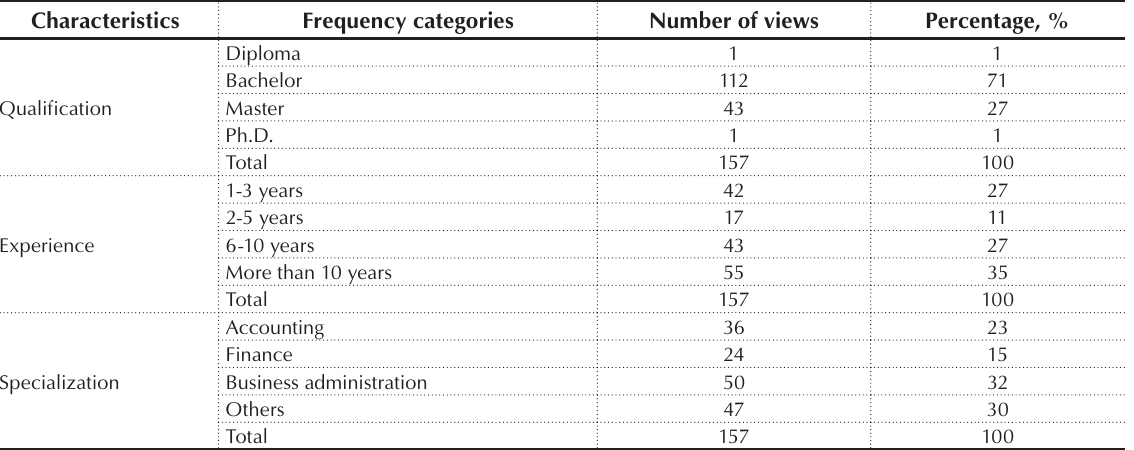
Table 3. (cid:100)(cid:346)(cid:286)(cid:3)(cid:282)(cid:349)(cid:400)(cid:410)(cid:396)(cid:349)(cid:271)(cid:437)(cid:415)(cid:381)(cid:374)(cid:3)(cid:381)(cid:296)(cid:3)(cid:400)(cid:410)(cid:437)(cid:282)(cid:455)(cid:3)(cid:400)(cid:437)(cid:271)(cid:361)(cid:286)(cid:272)(cid:410)(cid:400)(cid:3)(cid:258)(cid:272)(cid:272)(cid:381)(cid:396)(cid:282)(cid:349)(cid:374)(cid:336)(cid:3)(cid:410)(cid:381)(cid:3)(cid:410)(cid:346)(cid:286)(cid:349)(cid:396)(cid:3)(cid:258)(cid:272)(cid:258)(cid:282)(cid:286)(cid:373)(cid:349)(cid:272)(cid:3)(cid:395)(cid:437)(cid:258)(cid:367)(cid:349)(cid:302)(cid:272)(cid:258)(cid:415)(cid:381)(cid:374)(cid:400)(cid:853)(cid:3)(cid:400)(cid:393)(cid:286)(cid:272)(cid:349)(cid:258)(cid:367)(cid:349)(cid:460)(cid:258)(cid:415)(cid:381)(cid:374)(cid:3)